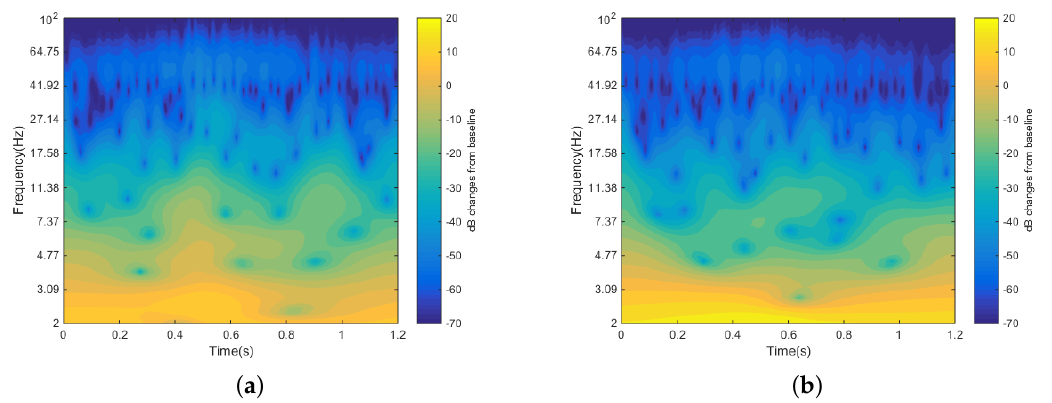
Figure 8. ( a ) First stimulus dB change from the baseline. ( b ) Last stimulus dB change from the